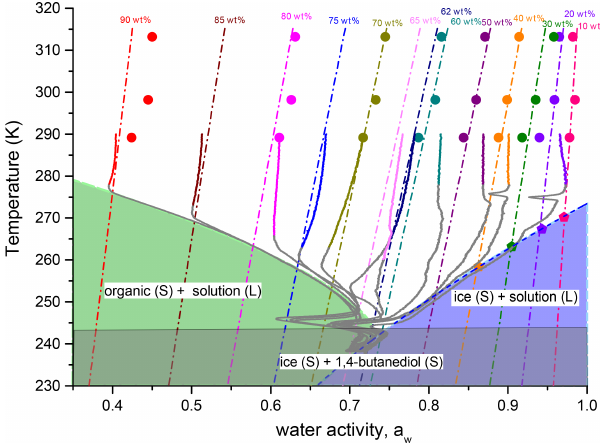
Figure 2. Measured water activities of aqueous 1,4-butanediol so- lutions vs. temperature. The different colours indicate the solution compositions in wt% of the organic component. The solid curves show data derived from the total gas phase pressure measurements. The coloured portion of the solid curves represents the temperature range for which the measurements are considered reliable within the uncertainty of the method ( ± 0.03 of a w ). Water activities de- rived from DSC measurements on the ice melting curve are repre- sented by pentagons. Bulk a w measurements using the water ac- tivity meter are represented by solid circles. The dash-dotted lines show the composition- and temperature-dependent a w parameteri- sation by Zobrist et al. (2008). The blue dashed line is the ice melt- ing curve (Koop and Zobrist, 2009). In the colour-shaded regions one or both components are supersaturated with respect to the solid phase and therefore, above the eutectic temperature ( ∼ 243–245K), at equilibrium one solid phase coexists with the remaining